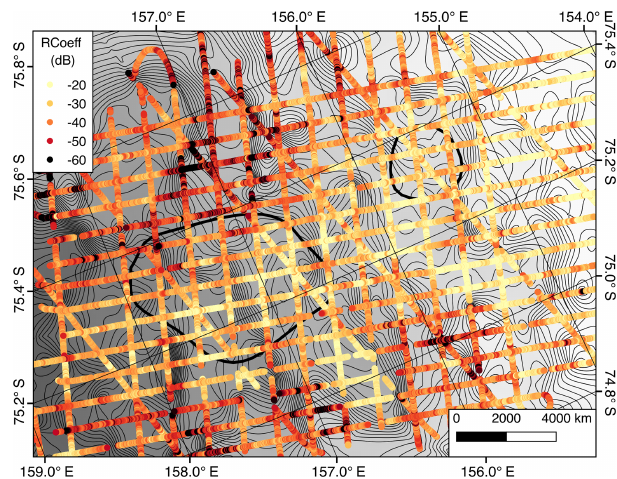
Figure 9. Relative reflection coefficients for the lake region, cor- rected for geometry and one-way dielectric losses of 15.1dBkm − 1 . The background consists of 10m contours for hydraulic potential, with hypothesized lake locations outlined in black (Smith et al.,